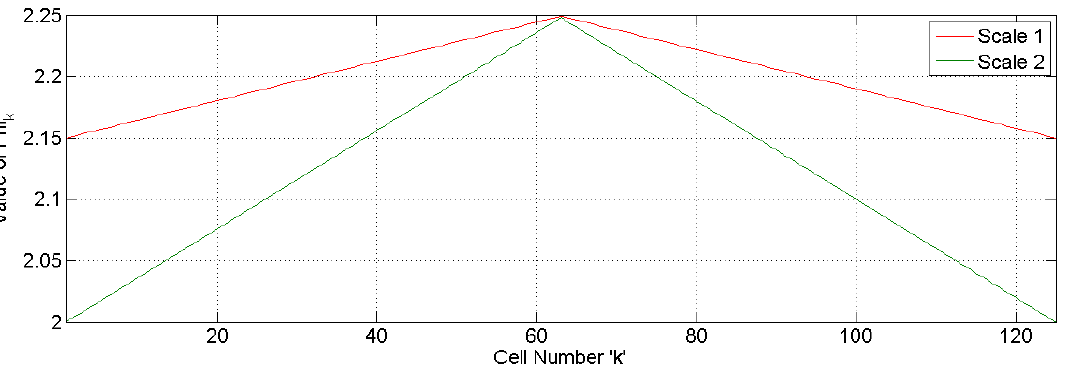
Figure 4. The values of φ k for different cells (LFP).